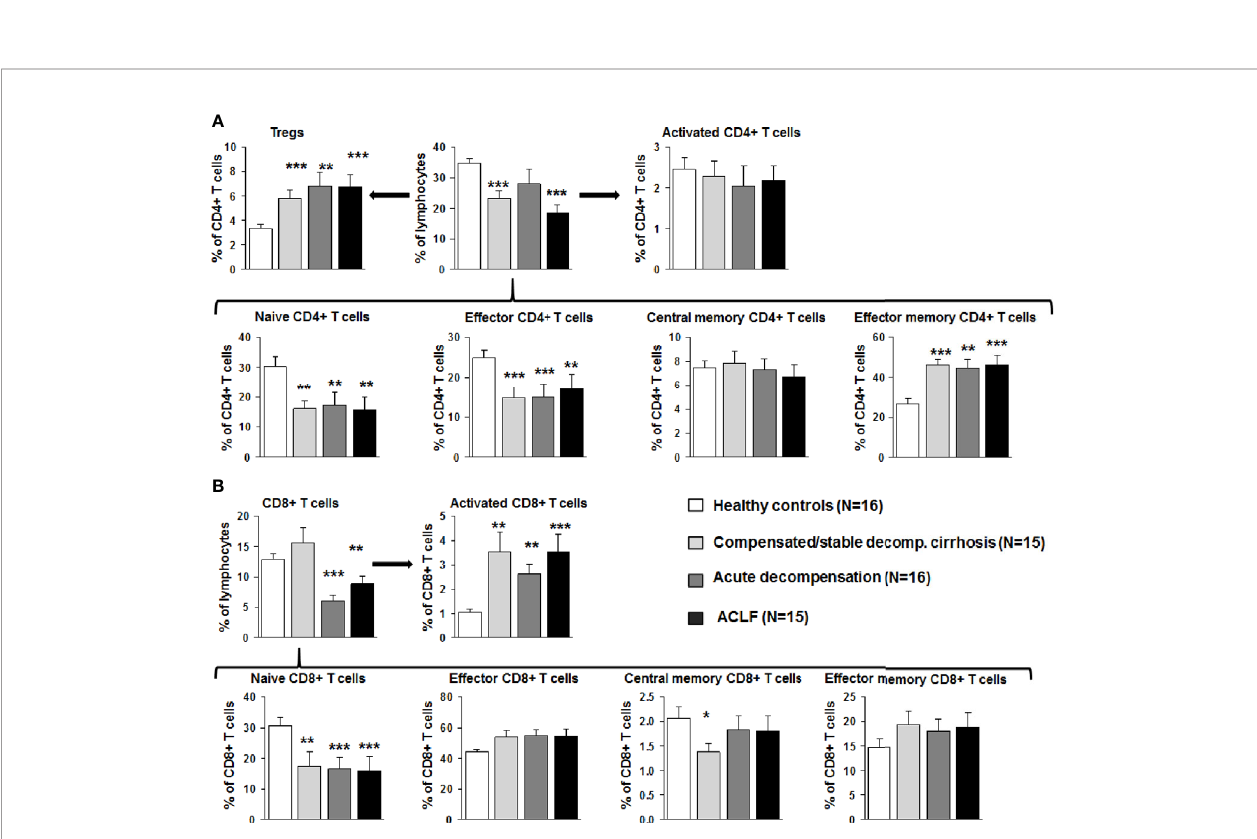
FIGURE 3 | Early changes of the ab T cell compartment during the course of liver cirrhosis. (A) CD4 positive T cells were stained for CD25 and CD127 to identify Tregs (top left), for CD38 and MHCII to assess T cell activation (top right), and for CD45RA and CD197 to further characterize the status of differentiation (bottom panel). Cell frequencies are represented as frequency of all living cells for total CD4 positive T cells (top middle) and as frequency of CD4+ T cells for all subtypes. (B) CD8+ positive T cells were stained for CD38 and MHCII to determine activation (top right), and for CD45RA and CD197 to characterize the status of differentiation (bottom panel). Cell frequencies are represented as frequency of all living cells for total CD8 positive T cells (top left) and as frequency of CD8+ T cells for all subtypes. * P <0.05, ** P <0.01, *** P